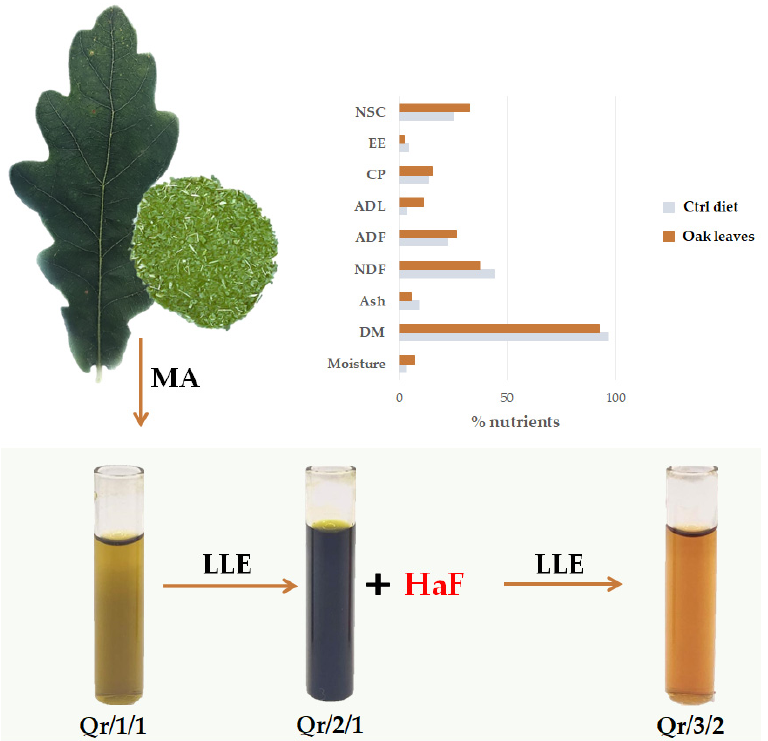
Figure 1. Quercus robur L. leaf chemical composition parameters expressed as % of DM and fractionation scheme to achieve bioactive fractions. DM: dry matter; NDF: neutral detergent fiber; ADF: acid detergent fiber; ADL: acid detergent lignin; CP: crude protein; EE: ether extract; NSC: no structural carbohydrates; MA: maceration; LLE: liquid–liquid extraction; HaF: hydroalcoholic